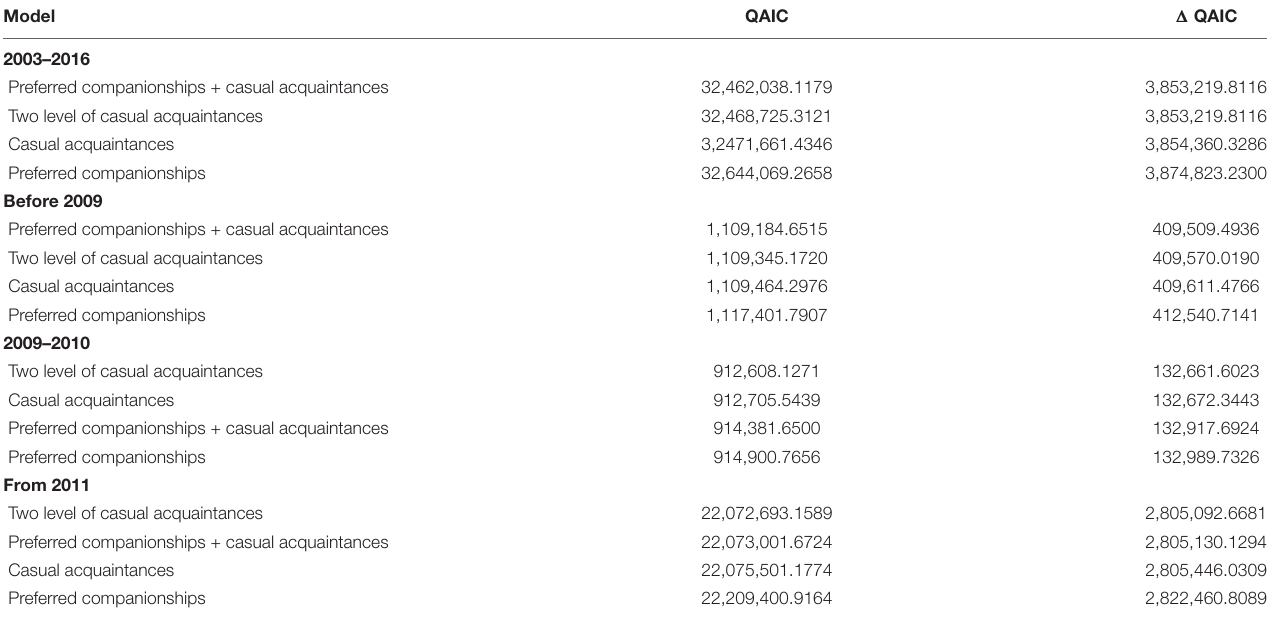
TABLE 4 | Model fitting to standardized lagged association rates (SLARs) among bull shark individuals for the entire study period, before 2009, between 2009 and 2010, and from 2011.